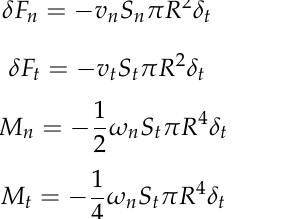
Table 2. Parameters of bonding bonds.